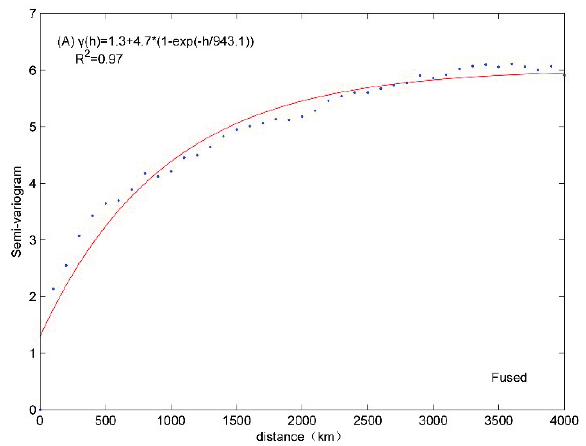
Figure 3. The experimental semivariograms and their fitting results for October 2010: ( A ) Fused CO ; ( B ) ACOS; and ( C ) 2